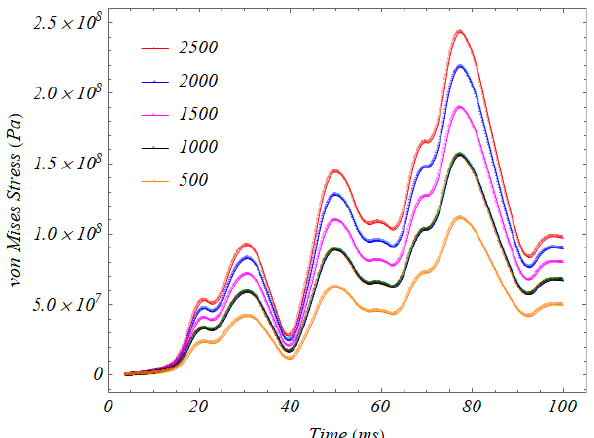
Fig.22. von Mises stress against time for various drop distances with three cellphone casing laminates.